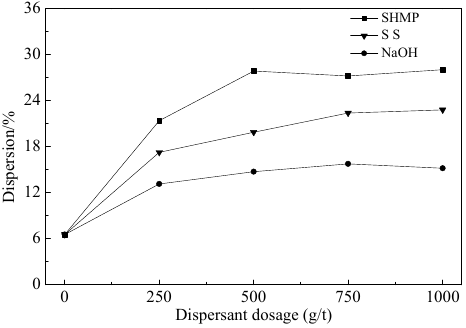
Figure 6. The effect of dispersants and their amounts.